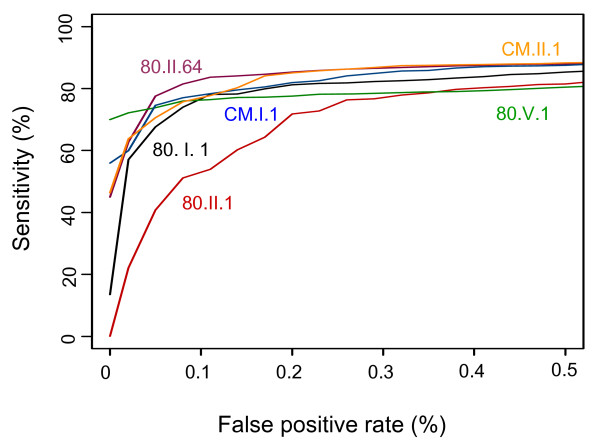
ROC-curves for selected normalizations. ROC-curvesfor six normalizations; 80.I.1 (black), 80.II.1 (red), 80.II.64 (darkred), 80.V.1 (green), CM.I.l (blue), and CM.II.l (yellow).